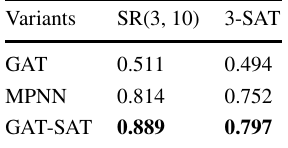
Bold values indicate the best